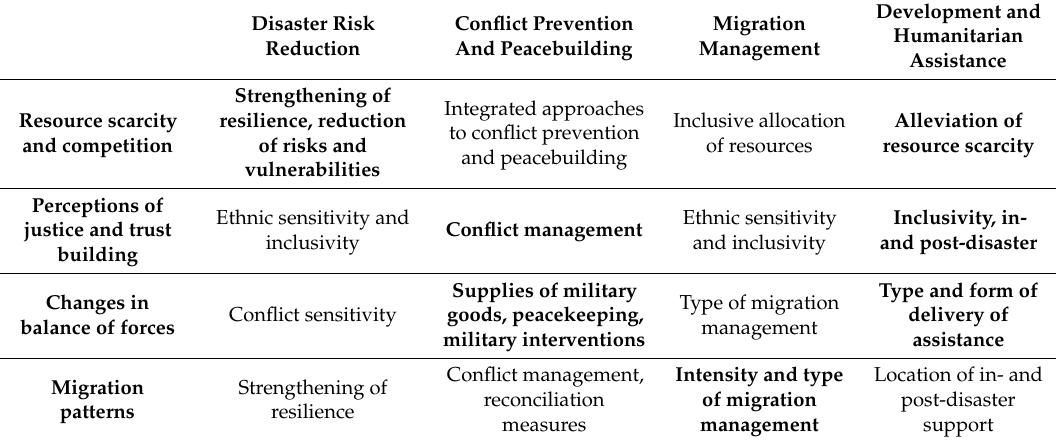
Table 3. International policy interventions and mechanisms in the disaster–migration–violent conflict nexus.